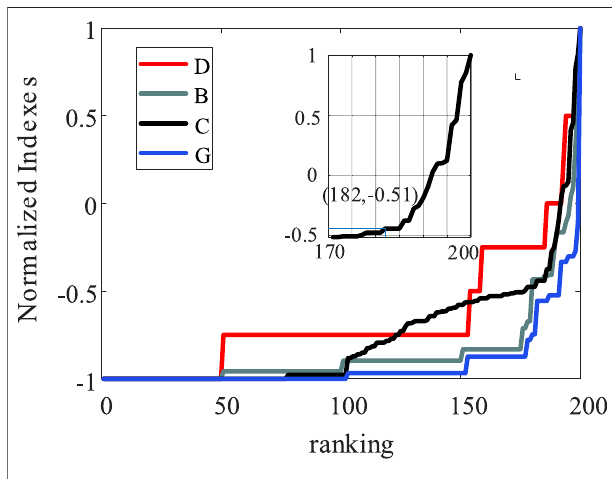
FIGURE 7 | Four indicators in descending order.